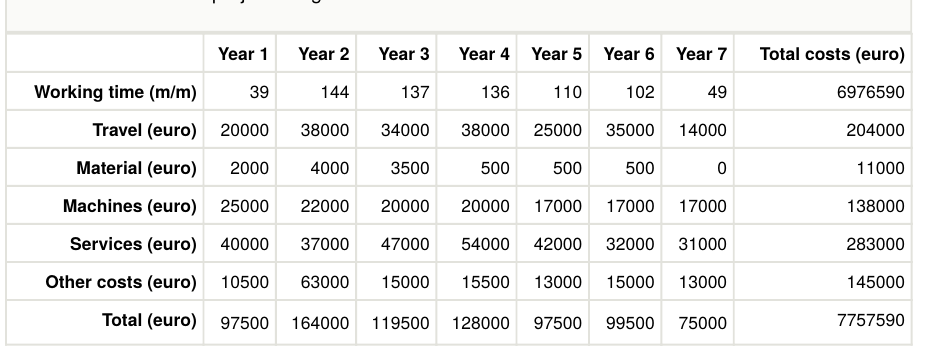
Estimated UNICORN-project budget based on Finnish unit